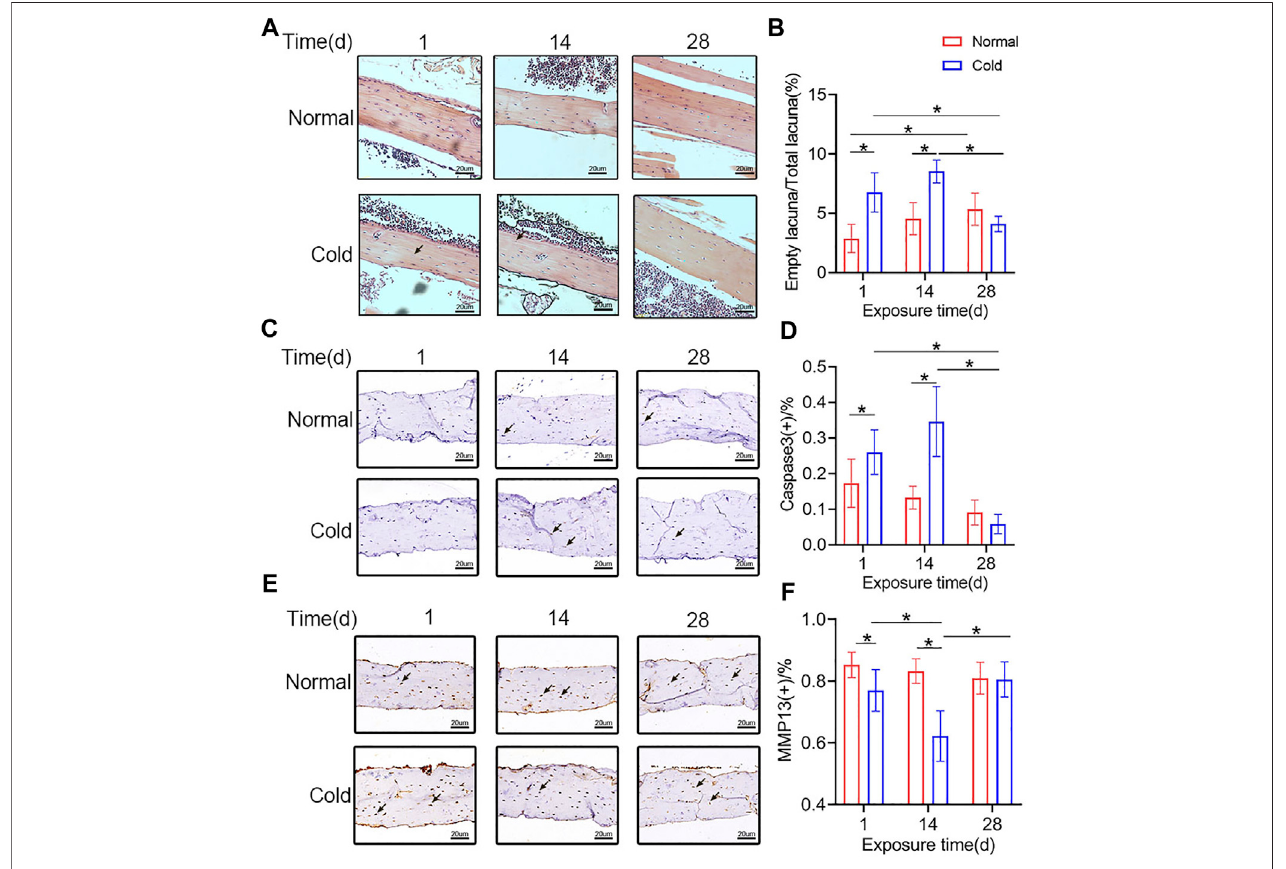
FIGURE 3 | Cold exposure induces osteocytes apoptosis. (A) Representative pictures of H and E staining in the femurs. (B) Quanti fi cation of empty lacunae in the Panel A . (C) Immunohistochemical stain of Caspase3 in the femurs was performed. (D) Caspase3-positive osteocytes are calculated and statistically represented. Black arrows: Empty lacuna or Caspase3 positive osteocytes. (E) Immunohistochemical stain of MMP13 in the femurs was performed. (F) MMP13-positive osteocytes are calculated and statistic results are shown. Black arrows: MMP13 positive osteocytes. Data are shown as mean ± SD ( n (cid:2) 5 per group). Signi fi cance ( p value) is calculated using two-way ANOVA, * p <